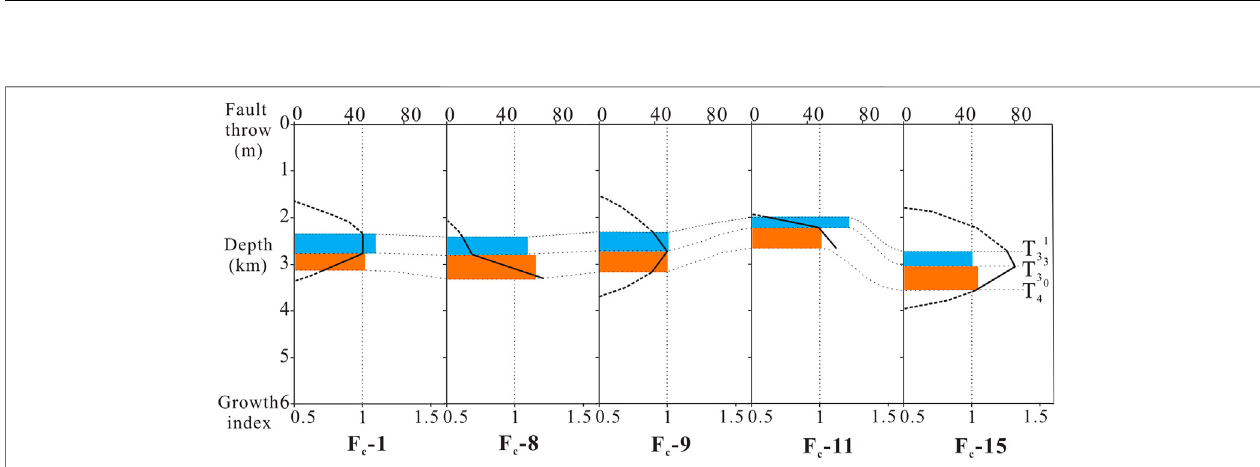
FIGURE 8 | Growth index and ‘ fault throw-depth ’ relationship curve (T-z pro fi le) of main faults. The blue, orange, and pink rectangles indicate the growth index, corresponding to the lower coordinate axis. The black polyline indicates the ‘ fault throw-depth ’ relationship curve, corresponding to the upper coordinate axis.